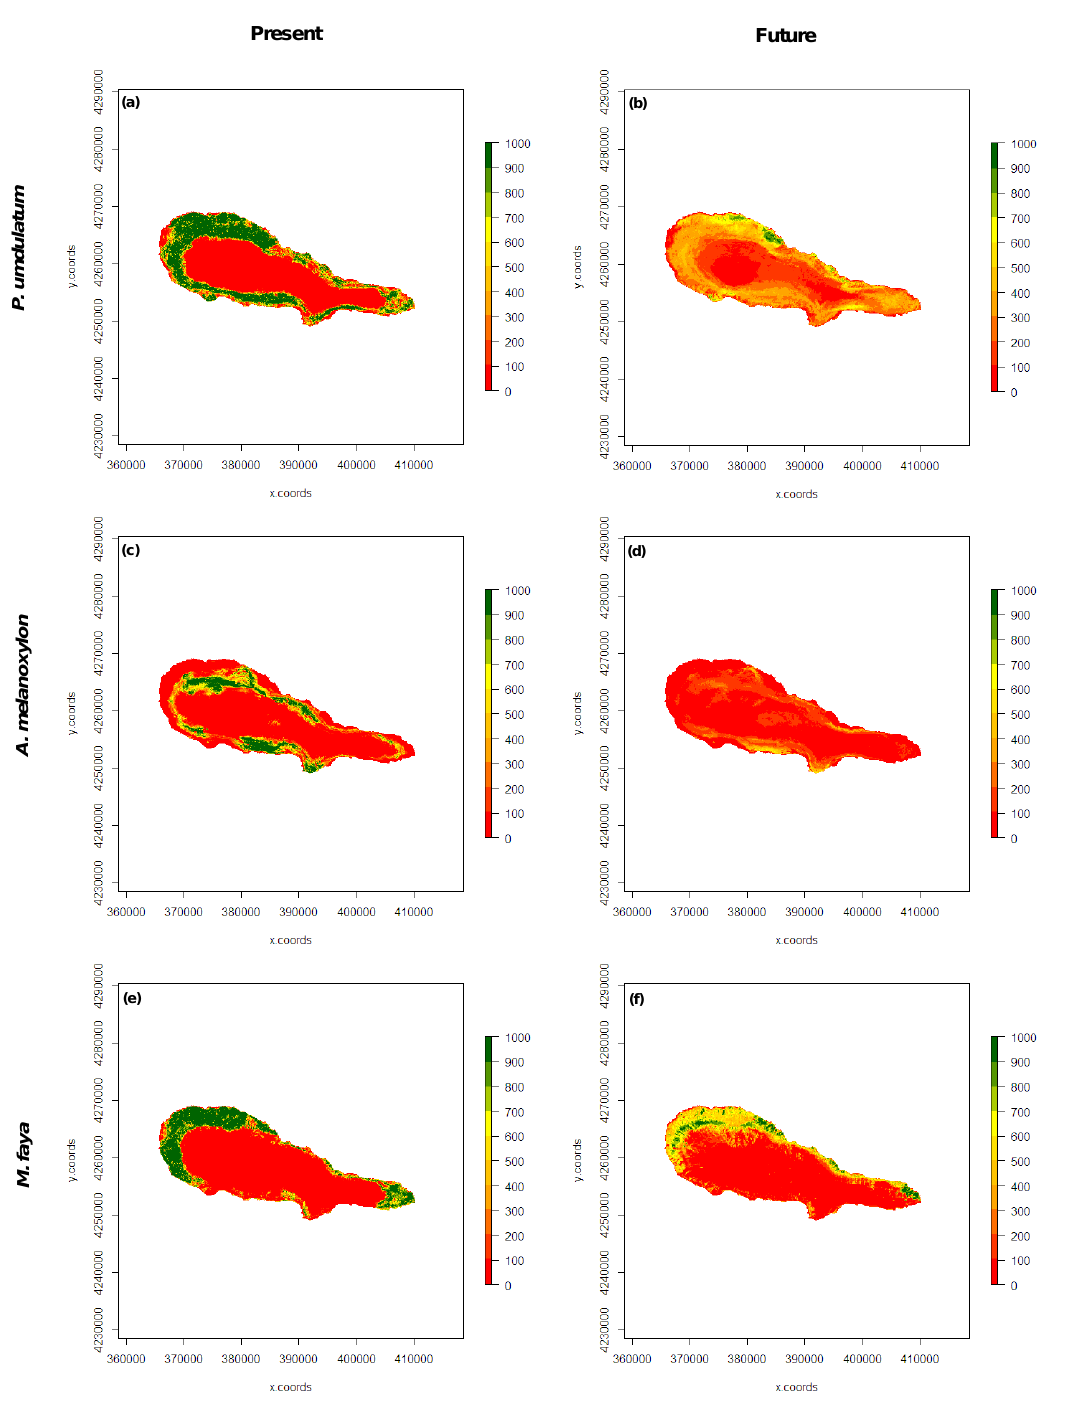
Figure 7. Present and future species distribution maps modelled for Pico Island: ( a , b ) P. undulatum , ( c , d ) A. melanoxylon, and ( e , f ) M. faya . Evaluation measure, AUC: Area under the receiver operating characteristic curve. EGV set 2. A probability scale from 0 to 1000 was used to facilitate map reading.